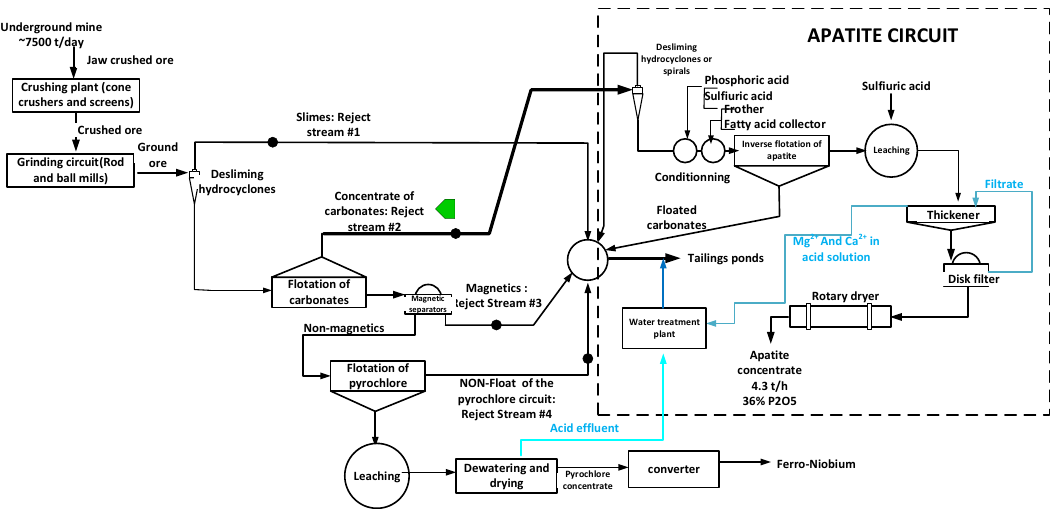
Figure 6. Niobec circuit including the proposed circuit for apatite concentration.